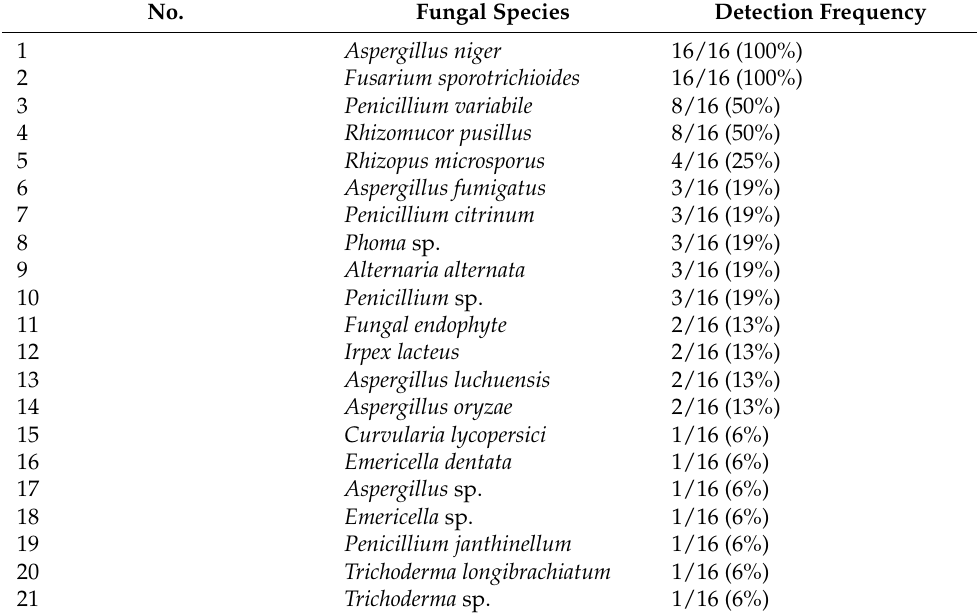
Table 4. Detection frequency of airborne